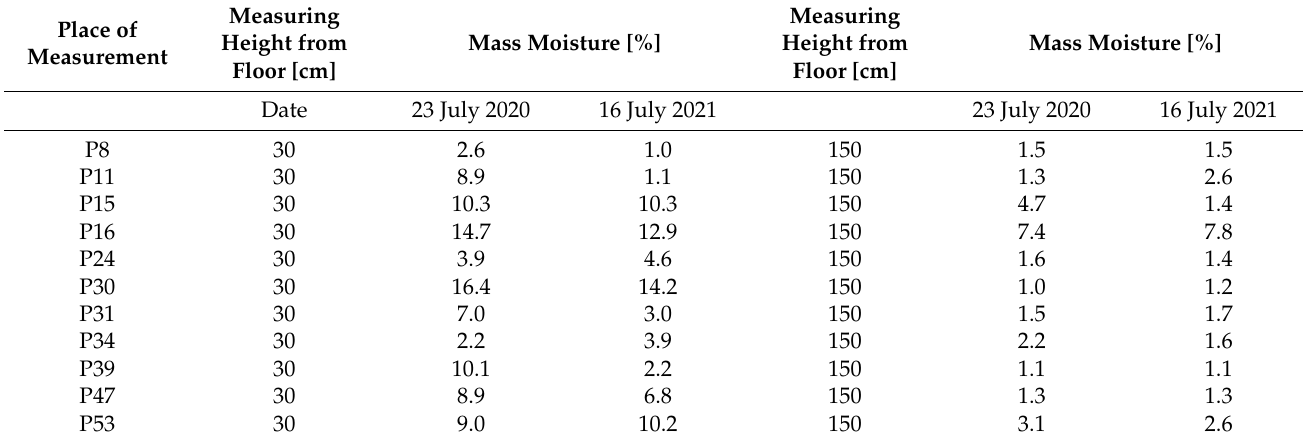
Table 4. Selected Moisture values in object with Applied Magnetokinesis Technology.